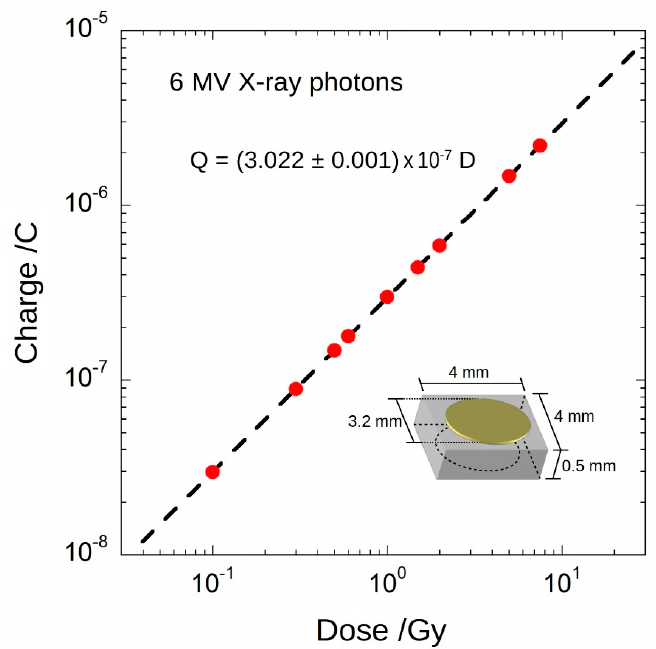
Figure 2. Charge as a function of dose acquired for 6-MV photon beam. Error bars are smaller than symbols. Sensitivity is about 302 nC/Gy, with a nonlinearity lower than 0.5% in the investigated dose range. In the inset, the contact structure and the detector dimensions are shown.